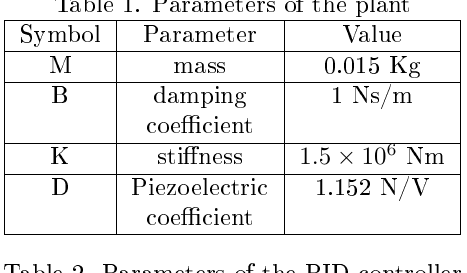
Table 2. Parameters of the PID controller Symbol